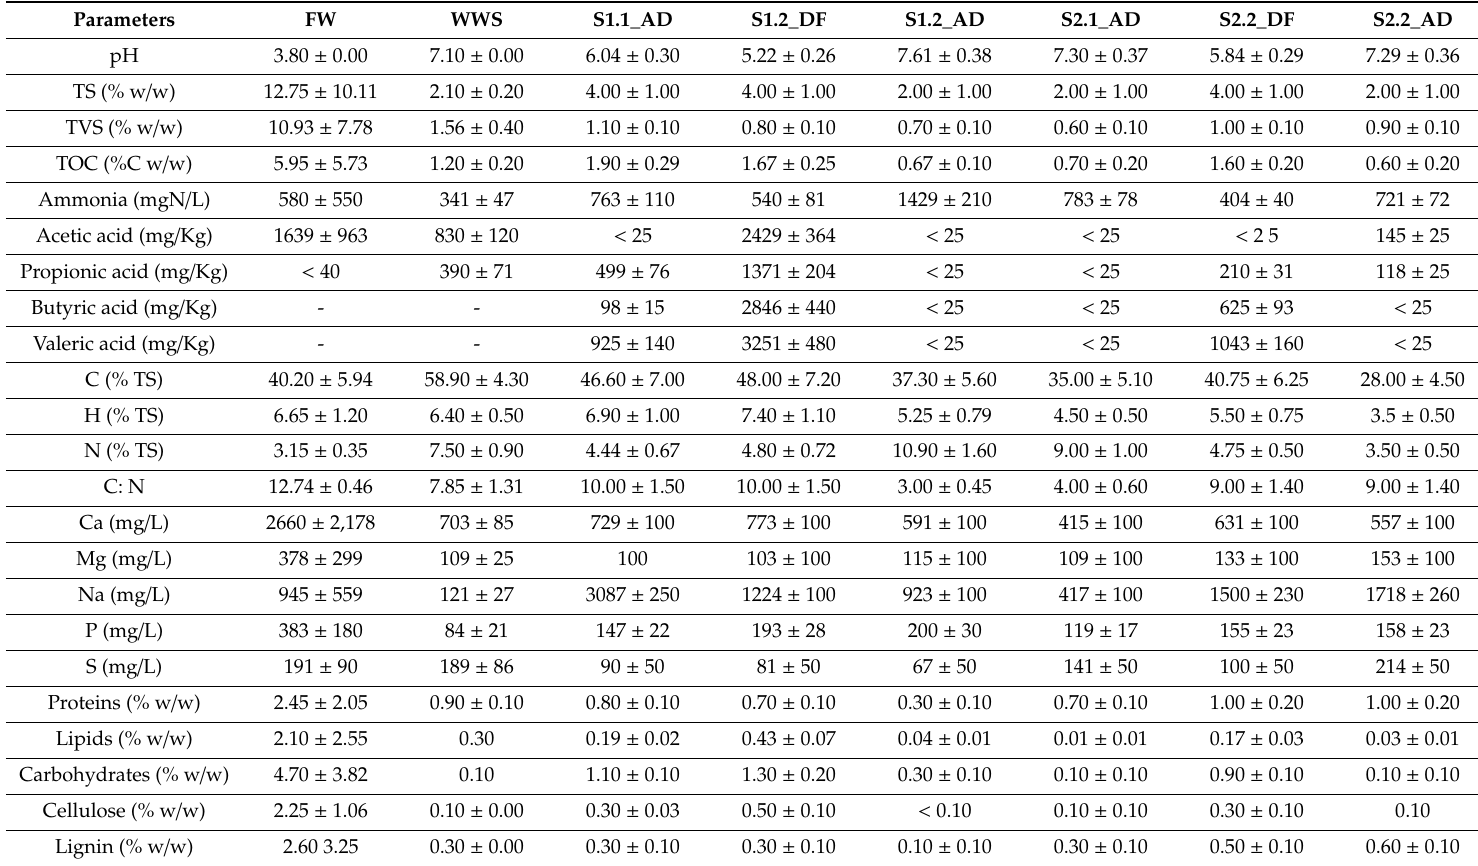
Table 2. Feedstocks and digestates characterization. Averages and standard deviations are presented (n = 2).